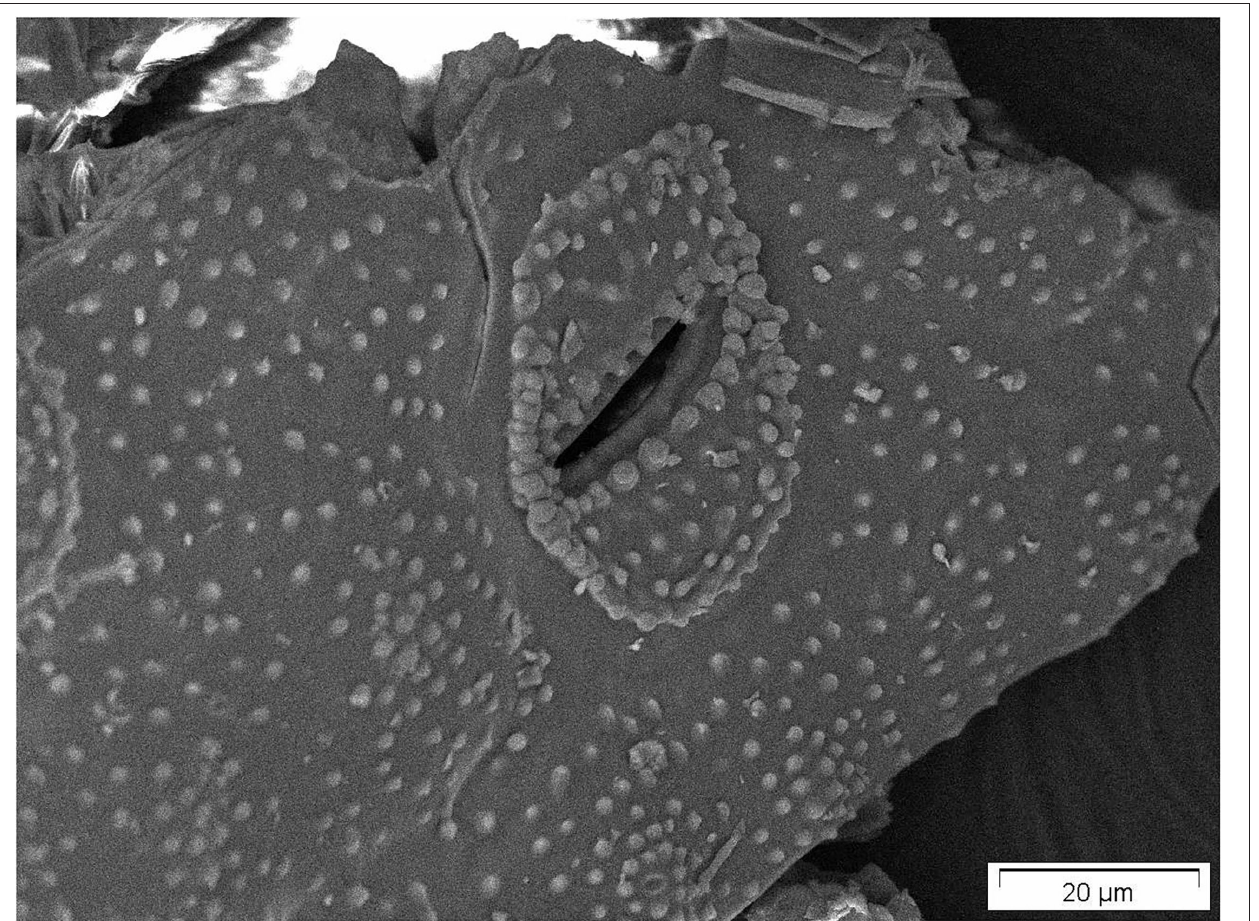
FIGURE 2 | Stomata of just dried common horsetail showing nicely subcuticular incorporated silica particles.